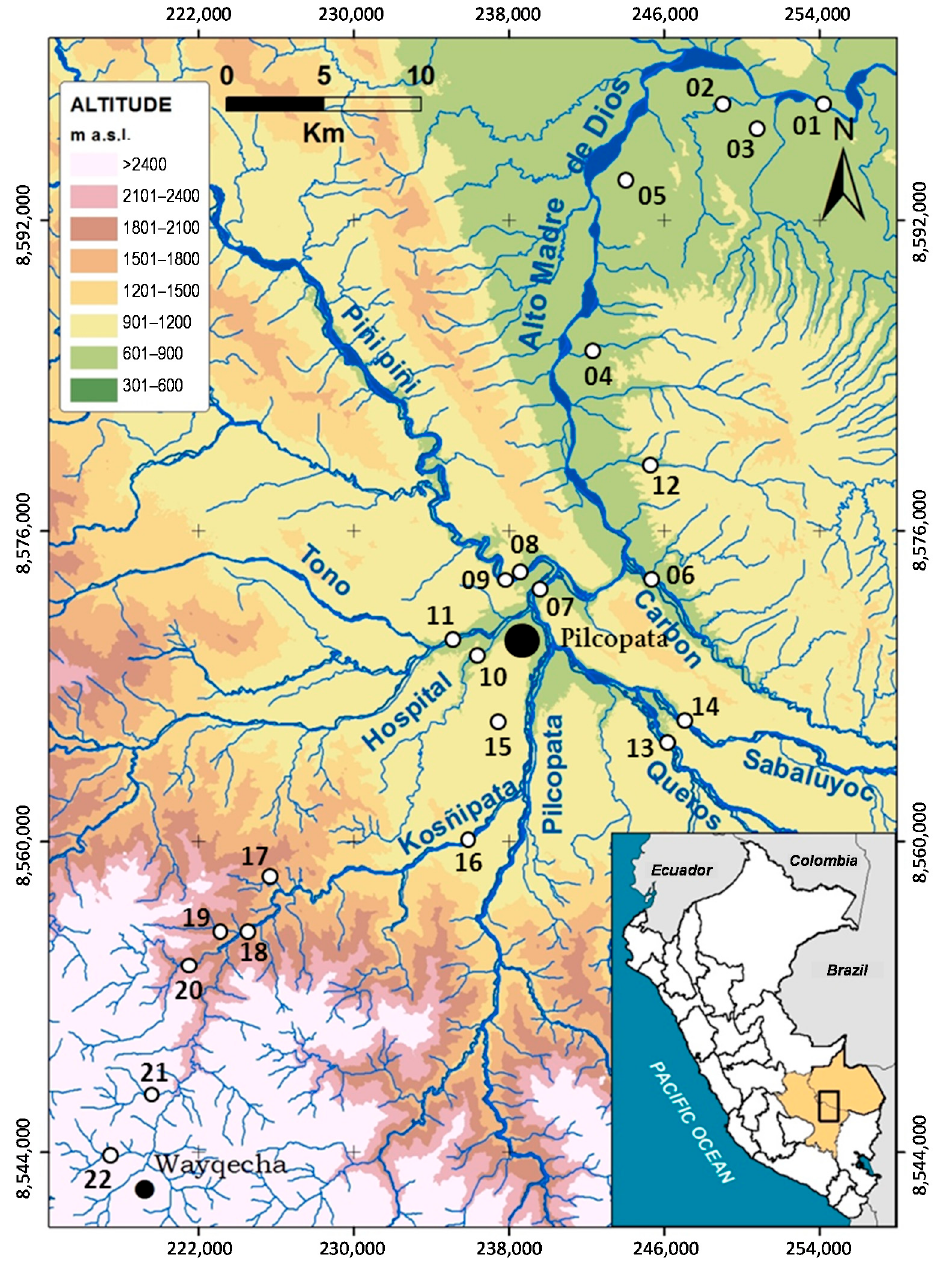
Figure 1. Sampling sites in the Alto Madre de Dios River, Peru (white circles).